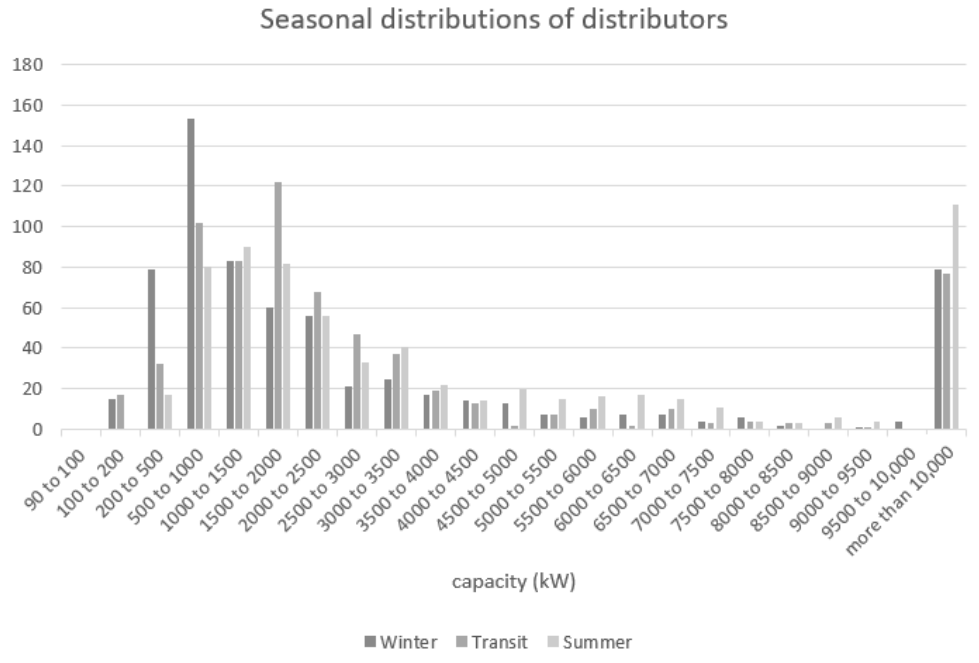
Figure 5. Distribution of distributors by sizes for 2050: critical scenario higher load and lower feed-in in the winter, transit, and summer periods.